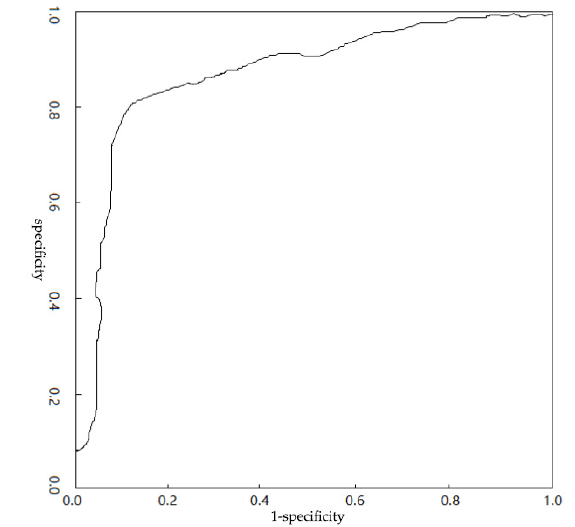
Figure 7. PSO-SVM-CSDPC disease prediction model ROC